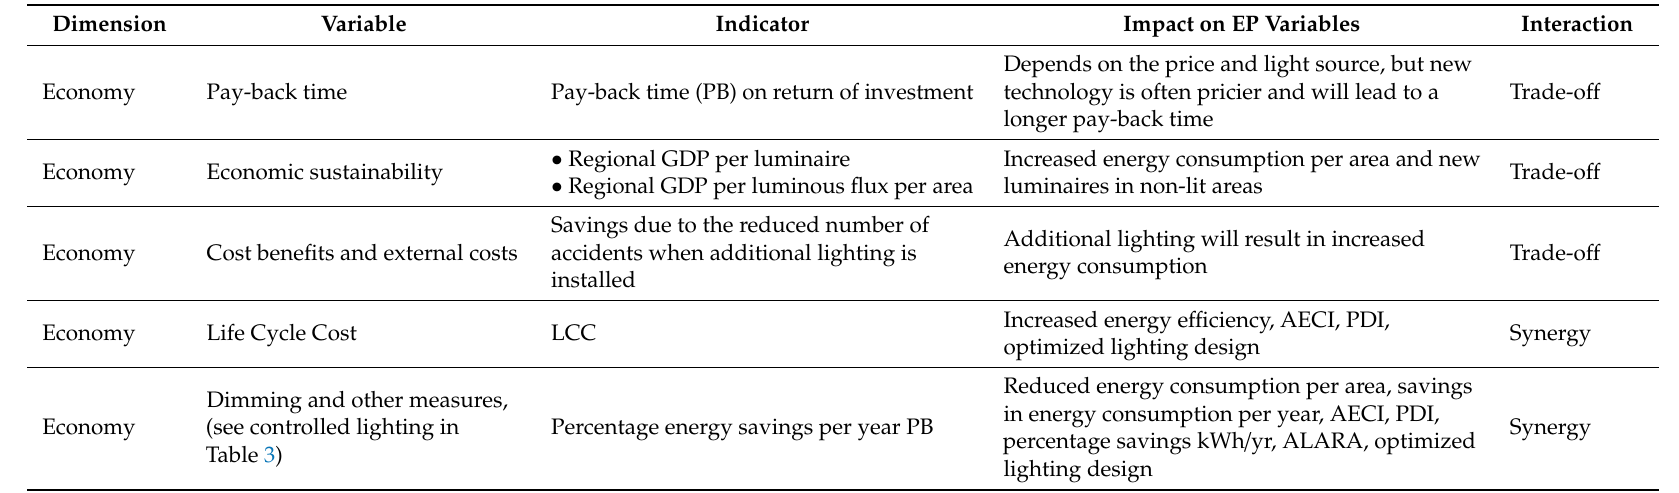
Table 4. Dimension, impact, and interaction between the sustainability indicators in the economic dimension and energy performance (EP)